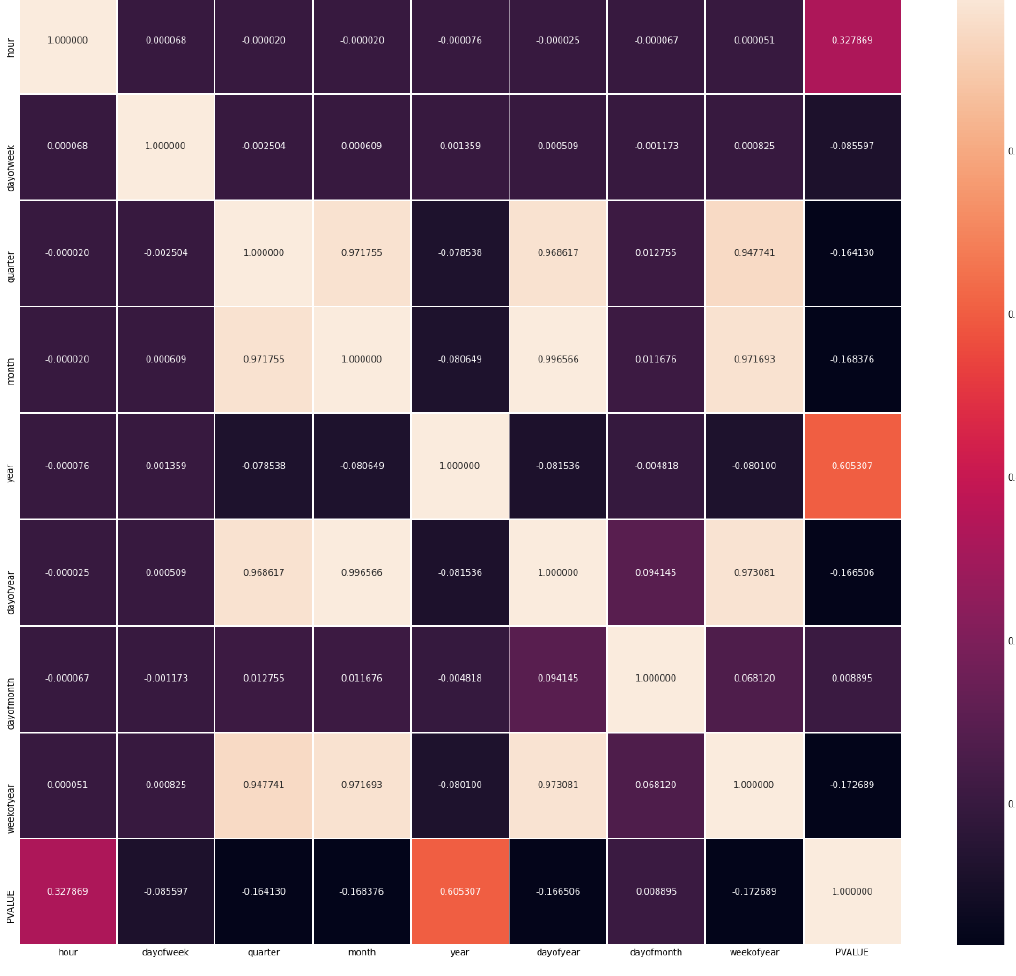
Figure 10. Correlation graph of the training data.